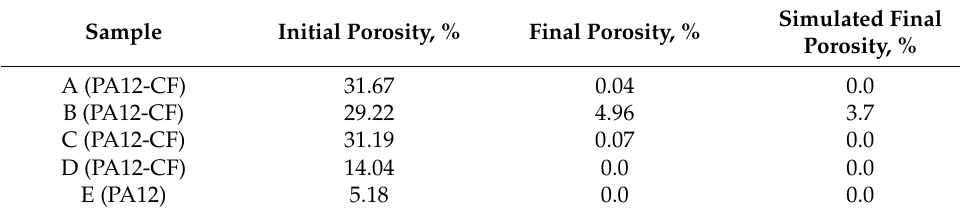
Table 4. Measured and simulated final